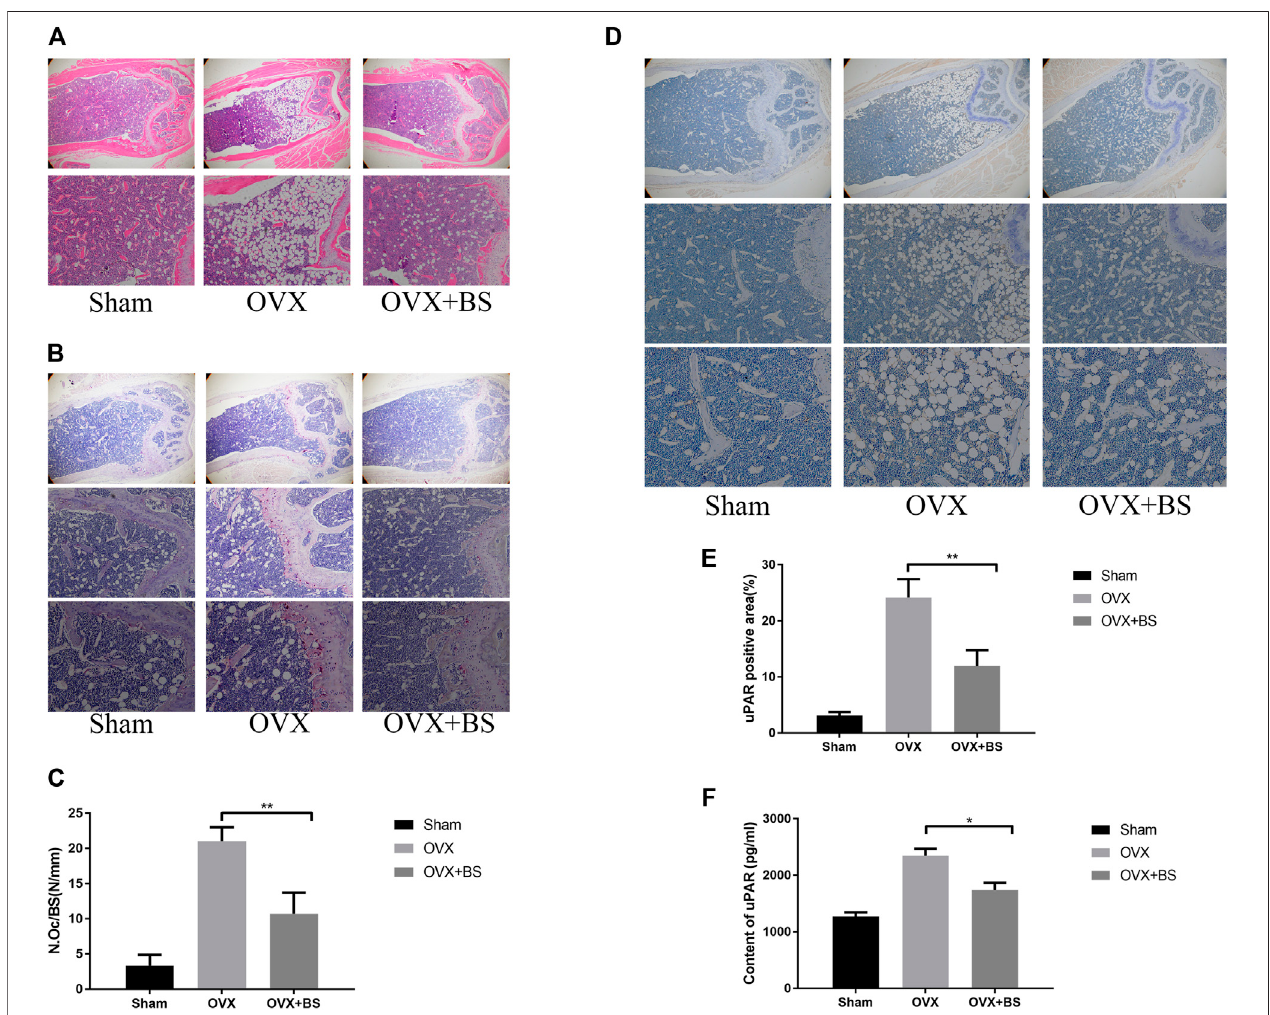
FIGURE9| BSreducedosteoclastnumberanddecreasedtheuPARlevelsinOVXmice. (A) HEstaining. (B) TRAPstaining. (C) QuantitationofTRAP-positivecells. (D) ImmunohistochemicalstainingforuPAR. (E) QuantitationofuPAR-positivecells. (F) TheserumlevelofuPARwasdetectedbyELISA.Allbargraphsarepresentedas mean ± SD; n = 10. p p < 0.05; pp p <